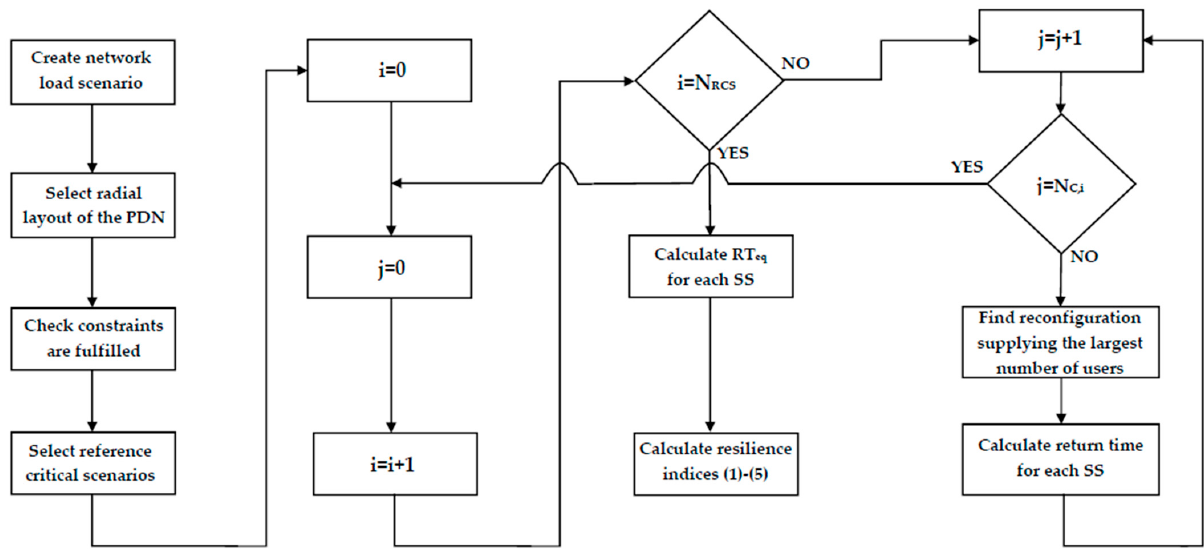
Figure 5. Flow chart of the procedure.